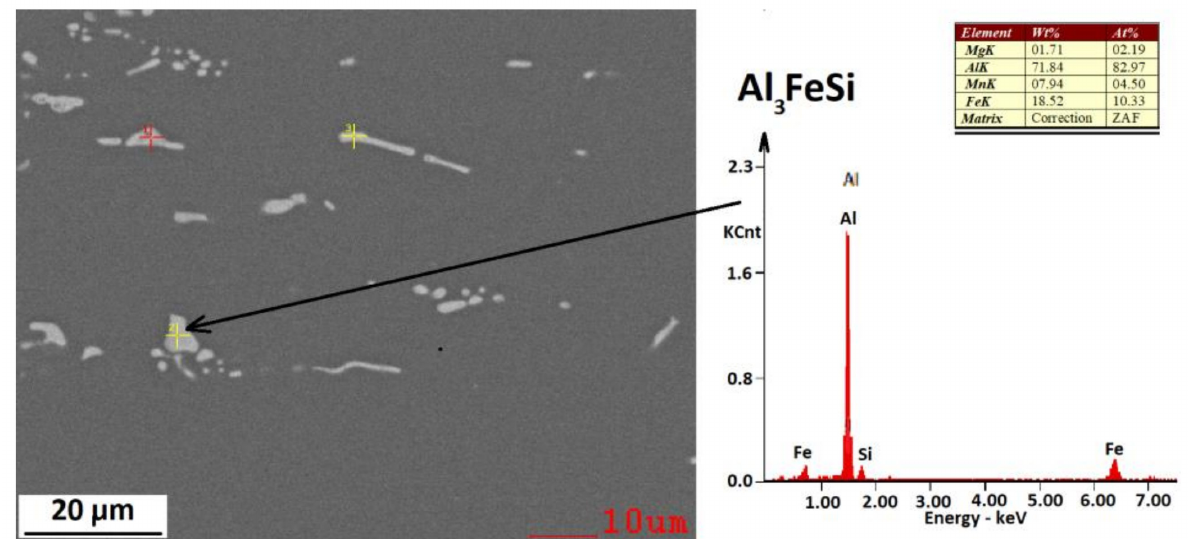
Figure 13. Chemical composition of the large intermetallic particles of the second phase in 8011